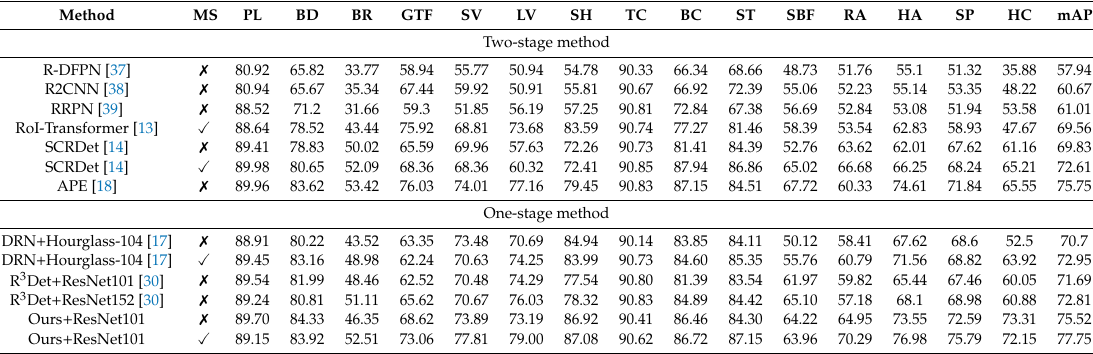
Table 1. Evaluation of the OBB task on the DOTA testing set. MS indicates that multi-scale images are used for testing. The abbreviations at the first line of this table can be referred to the introduction of DOTA at Section 4.1.